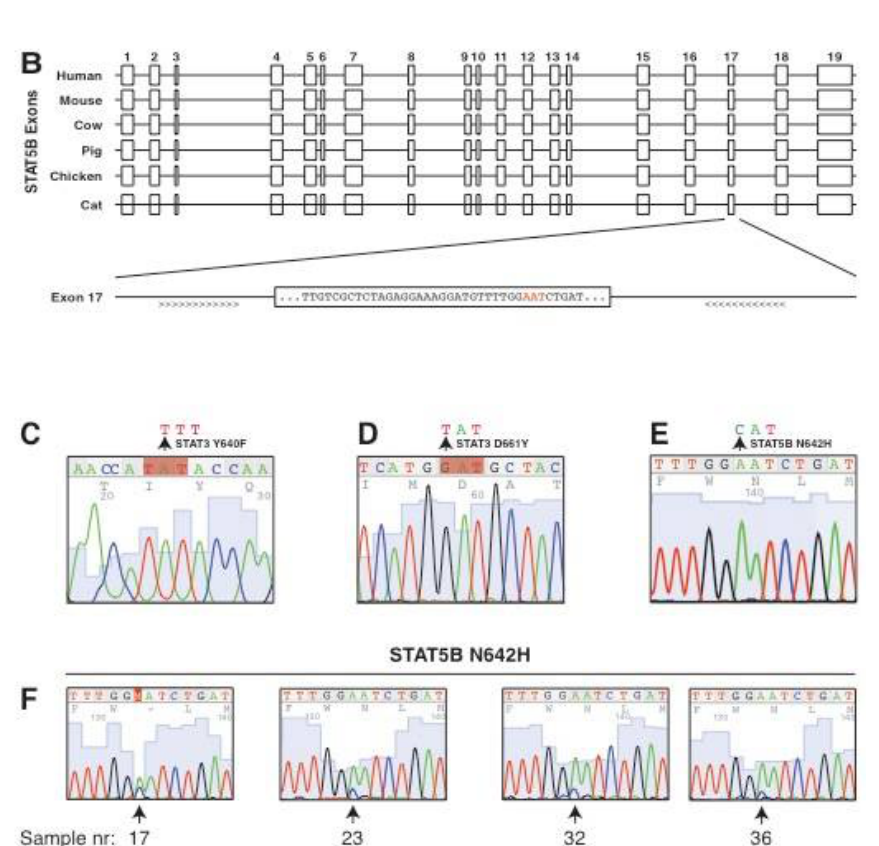
Figure 4. Conservation of the intron–exon structure of STAT3 and STAT5B and screening for candidate activating mutations. ( A ) Schematic representation of the sequence alignment of STAT3 from the indicated species. Exons are drawn as boxes with their numbers given above, introns as lines. The lower panel is a close-up of exon 21 from the genomic sequence of feline STAT3 . The sequence shows that two codons (red) representing mutational hotspots in human and murine STAT3 are conserved in feline STAT3 . ( B ) Schematic representation of the sequence alignment of STAT5B from the indicated species as in A. Exons are drawn as boxes with their numbers given above, introns as lines. The lower panel is a close-up of exon 17 from the genomic sequence of feline STAT5B . The sequence in the box represents part of exon 17 surrounding the codon corresponding to N642, which is also present in feline STAT5B . ( C – E ) Examples of Sanger sequencing of nucleotides encoding for the amino acids Y640 ( C ) and D661 ( D ) of STAT3 and N642 ( E ) of STAT5B . Arrows indicate the position of the nucleotide that is changed in known activating mutations (Y640F: TAT → TTT, D661Y: GAT → TAT, N642H: AAT → CAT). Primers as indicated in A were used to amplify exon 21 of STAT3 ( C , D ) and exon 17 of STAT5B ( E ). ( F ) Results from Sanger sequencing of lymphoma samples for the N642H mutation of STAT5B . Indicated samples show minor peaks for the N642H mutation of STAT5B , corresponding to an A to C conversion. Position and sample number are indicated by an arrow below each panel.